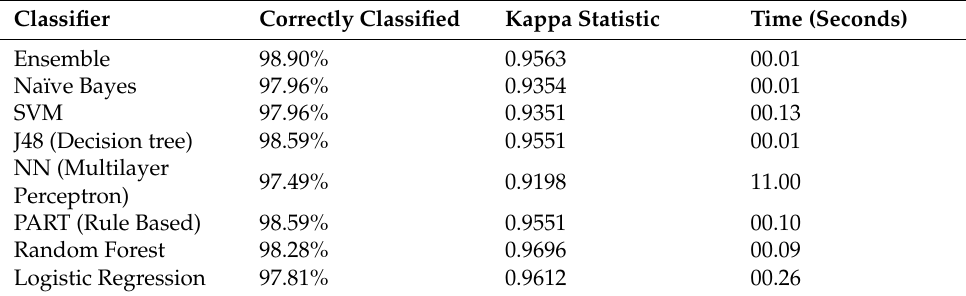
Table 5. Performance of classification algorithms.